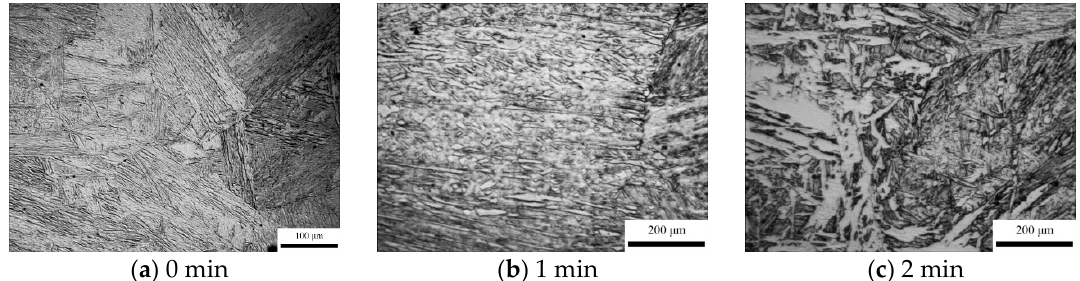
4 of 14 Figure 3. Change of relative radial expansion Δ L / L with temperature of slab under a continuous cooling rate of 10 °C/s. Figure 4. Change of phase transformation f with temperature. To figure out the preservation time, 1#, 2#, and 3# samples were heated to 1350 °C, held for 5 min, cooled to 600 °C with a cooling rate of 10 °C/s, held for 0 min, 1 min, and 2 min, and then quenched. The microstructures of the samples after etching (4 vol % nitric acid alcohol) are shown in Figure 5. As shown in Figure 5a, the microstructure of 1# quenched sample was mainly composed of martensite that was unchanged austenite at a high temperature, and lots of spots distributed around the grain boundary mainly due to the etched pro ‐ eutectoid ferrite. As shown in Figure 5b, the microstructure of 2# quenched sample was mainly composed of large number of granular ferrite and